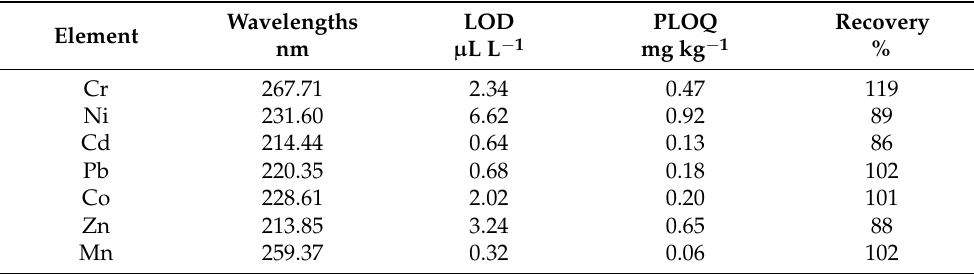
Table 1. Wavelength, limit of detection (LOD), quantification (PLOQ), and percent recovery from